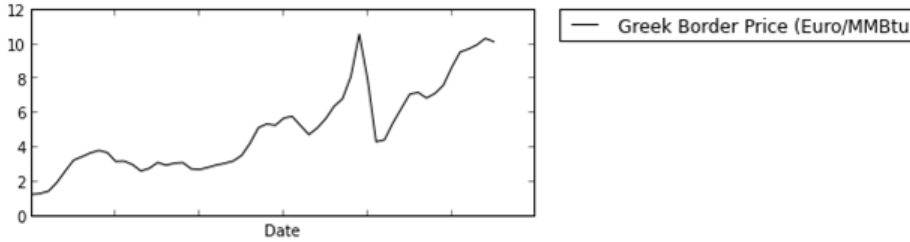
Figure 3. Evolution of the Greek border price for natural gas imports: The figure depicts the rapid increase in the price of the natural gas imports versus time for the case of Greece.